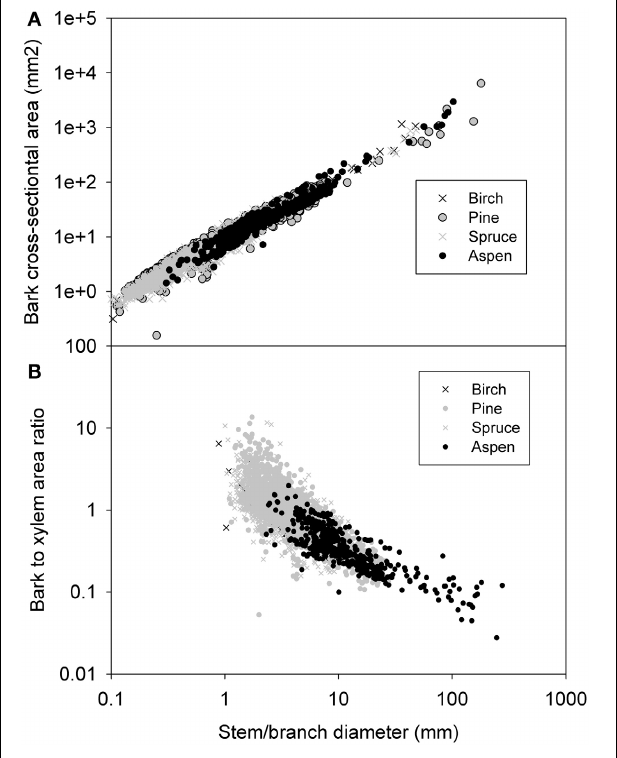
FIGURE 1 | Measured bark cross-sectional (A) and the ratio of bark to xylem cross-sectional area (B) as a function of stem/branch